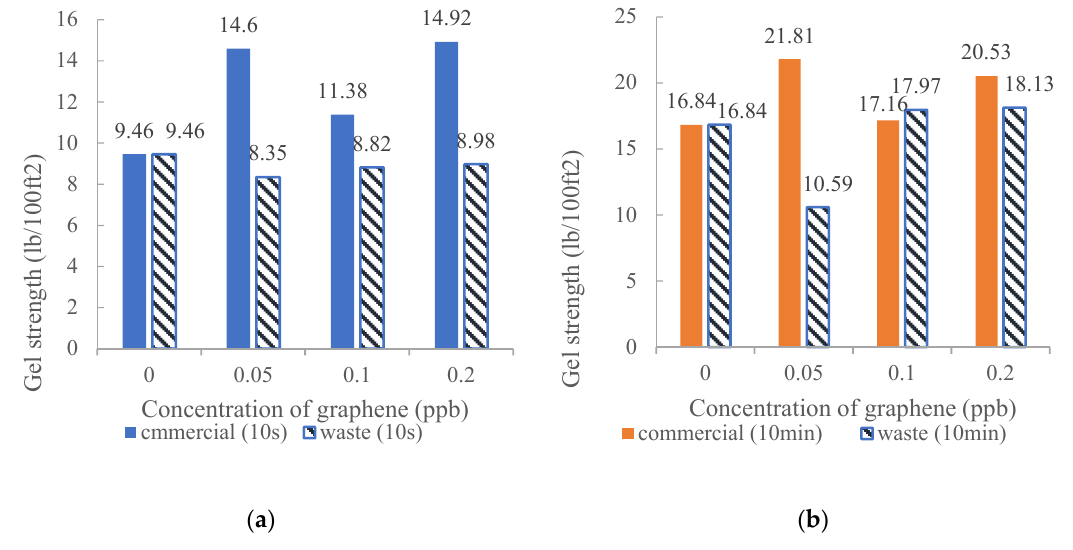
Figure 2. Gel strengths of different concentration of graphene before aging: ( a ) 10 s and ( b ) 10 min. Reproduced with permission from [61]. Copyright IOP Publishing, 2020.